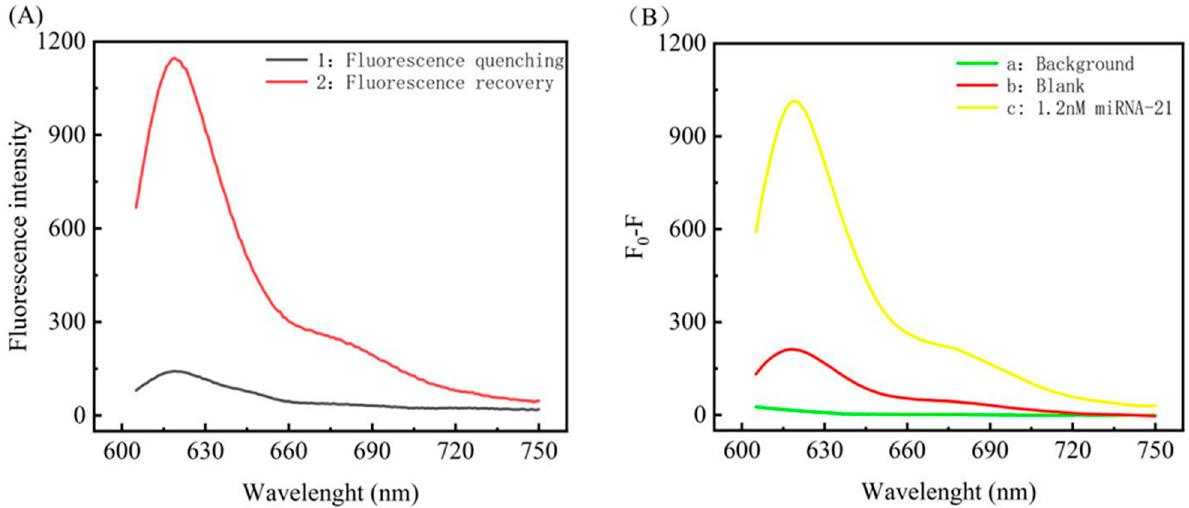
Figure 3. ( A ) Fluorescence emission spectra of the system under different conditions. Curve 1 shows the burst effect of AuNPs–DNA on fluorescence in the reaction system in the presence of miRNA-21. Curve 2 shows the fluorescence recovery upon adding DNA-d and IMB under the same conditions as those of curve 1. ( B ) Effect of the system on fluorescence under different conditions. a shows the background signal of the reaction system, b shows the effect on fluorescence in the absence of miRNA-21, and c shows the effect of AuNPs–DNA on fluorescence in the presence of miRNA-21.